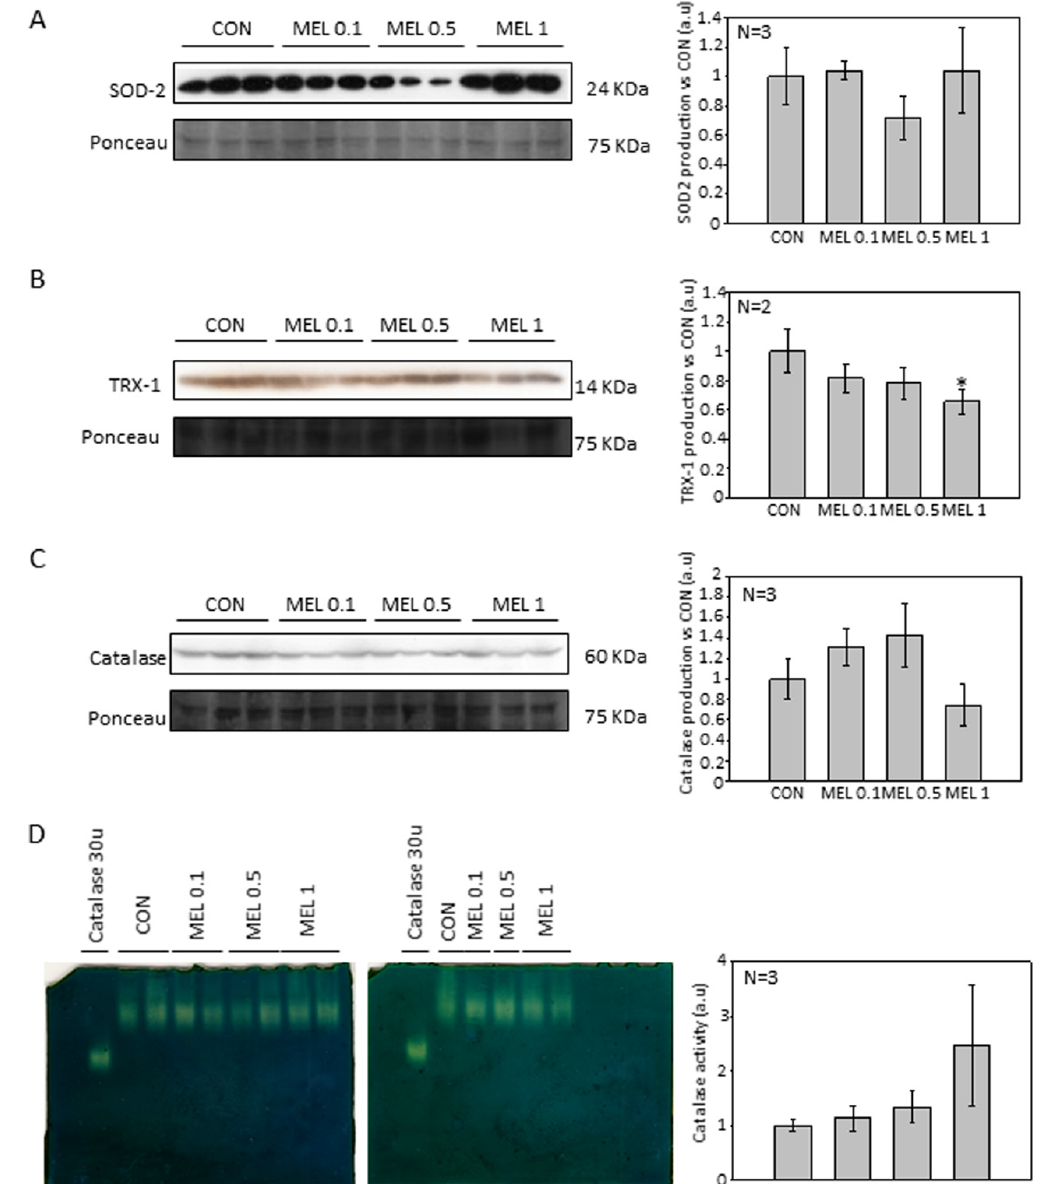
Figure 7. Study of redox proteins included in hydrogen peroxide production and scavenging after melatonin treatment. ( A ) SOD2 total protein production. ( B ) TRX ‐ 1 total protein production. ( C ) Catalase total protein production ( D ) Catalase activity gel. Data were shown as average +/ − SEM. Significance vs. CON. * P < 0.05.